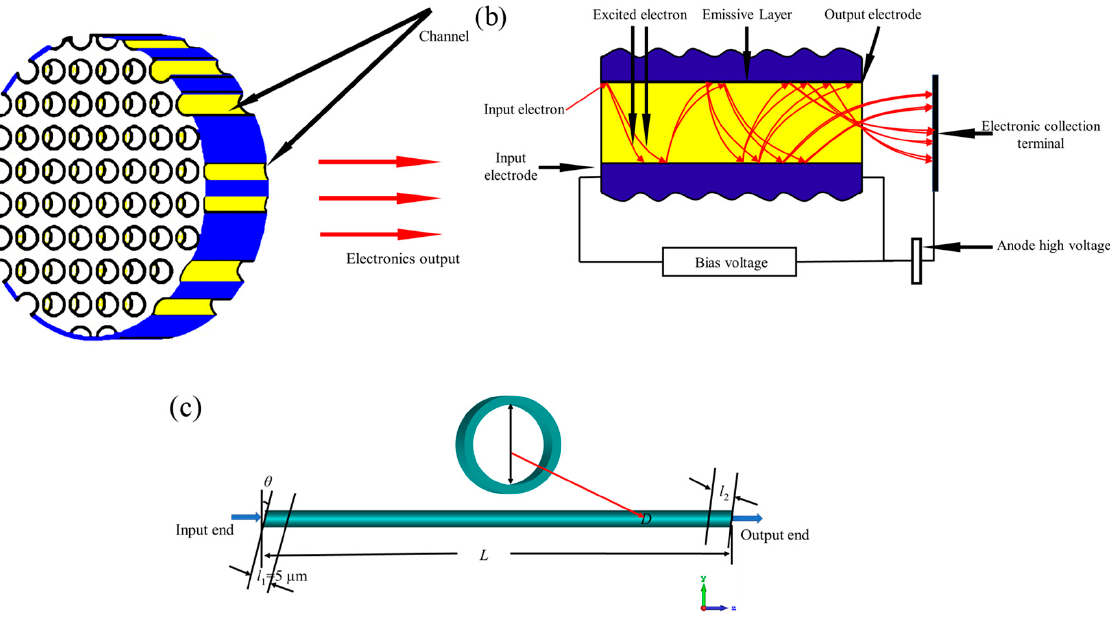
Figure 1. MCP multiplication process and model construction: ( a ) Microchannel plate structure; ( b ) Single channel electron multiplication principle; ( c ) 3D single channel model.